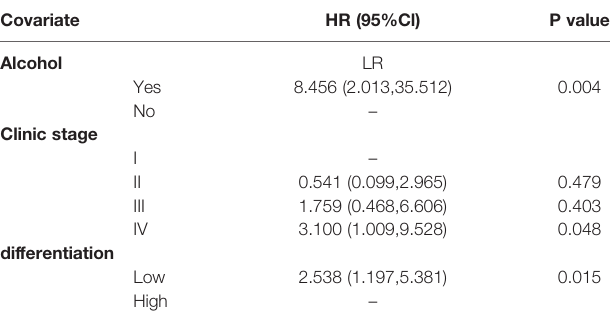
TABLE 3 | Multivariable Cox proportional hazard models of mortality.